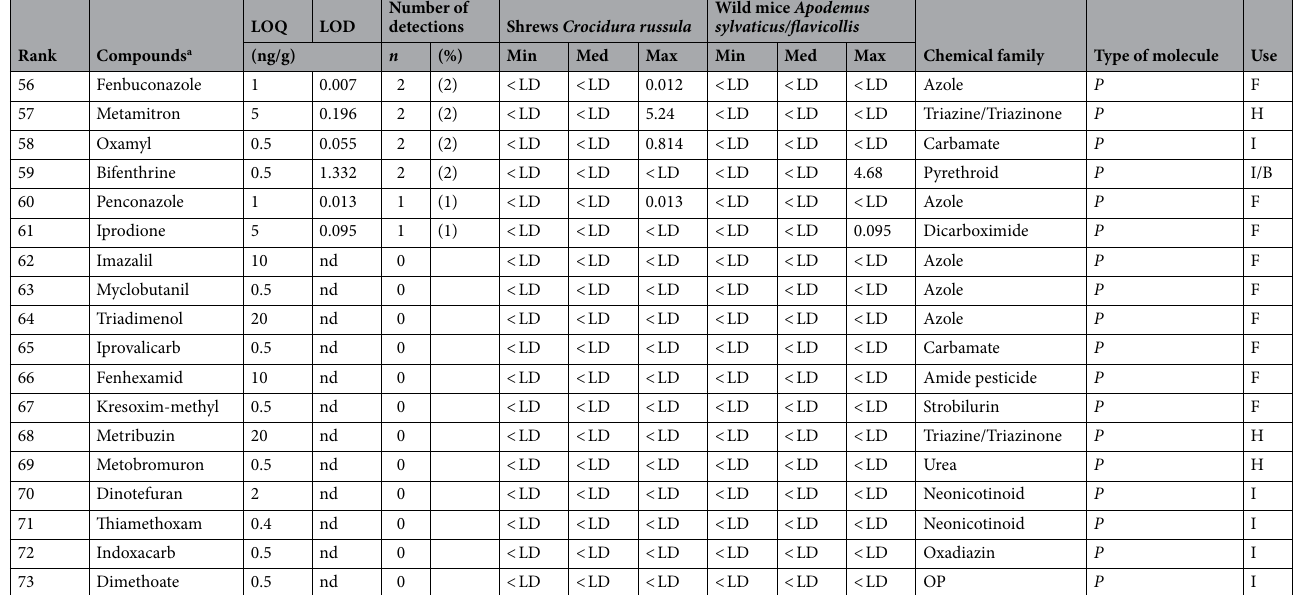
Table 2. Concentrations of currently used pesticides (CUPs) in small mammal hair samples, ordered by decreasing number of detection. Maximum concentrations higher than 10 ng/g are in bold. Abbreviations in headers and values: LOQ , limit of quantification; LD , Lowest detected value ( nd , not detected); Min , minimum; Med , median; Max , maximum. Abbreviations for chemical family and type of molecule: OP , Organophosphorous; OC , Organochlorine; P , parent molecule; M , metabolite. Abbreviations for type of use: B , biocide; F , fungicide; H , herbicide; I , insecticide; R , rodenticide. *Also a metabolite of Thiametoxam. a List of abbreviations: Br 2 CA: acid 3-(2,2-dibromo-vinyl)-2,2-dimethylcyclopropane-carboxylic;